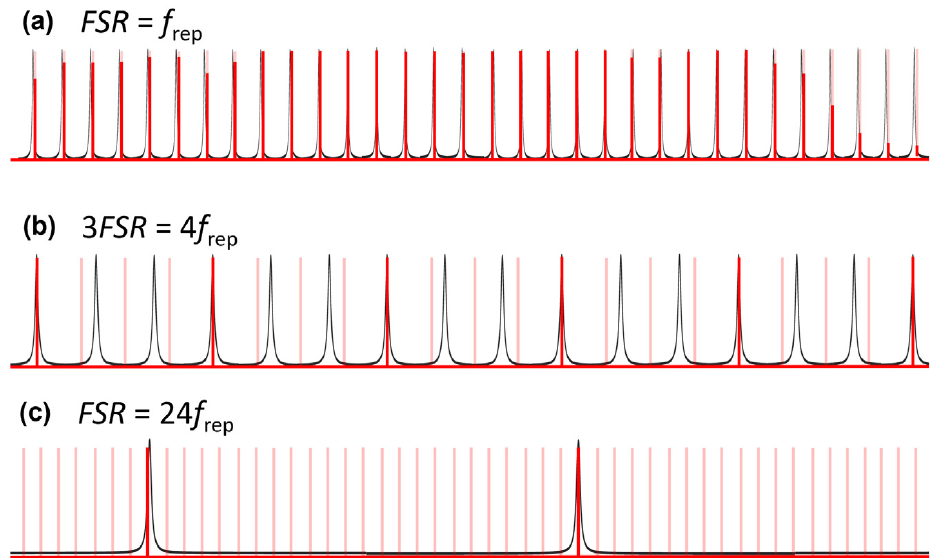
Figure 1. Comb–cavity coupling in ( a ) the perfect match case including the influence of cavity dispersion, and for two different Vernier ratios: ( b ) 4/3 and ( c ) 24/1. The cavity resonances are depicted by the solid black curves, and the comb modes are shown by the red bars (the incident comb spectrum is shown by the shaded bars, while the transmitted modes are shown by the solid bars).